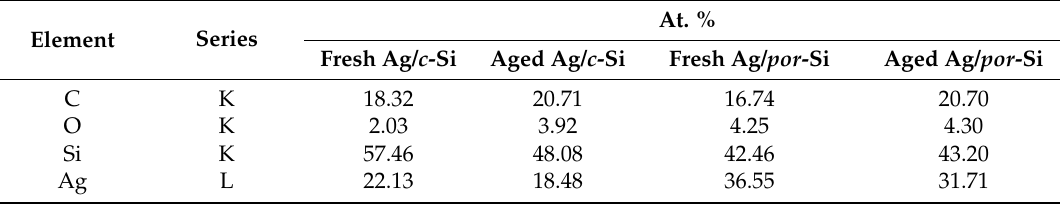
Table 1. Results of the EDX